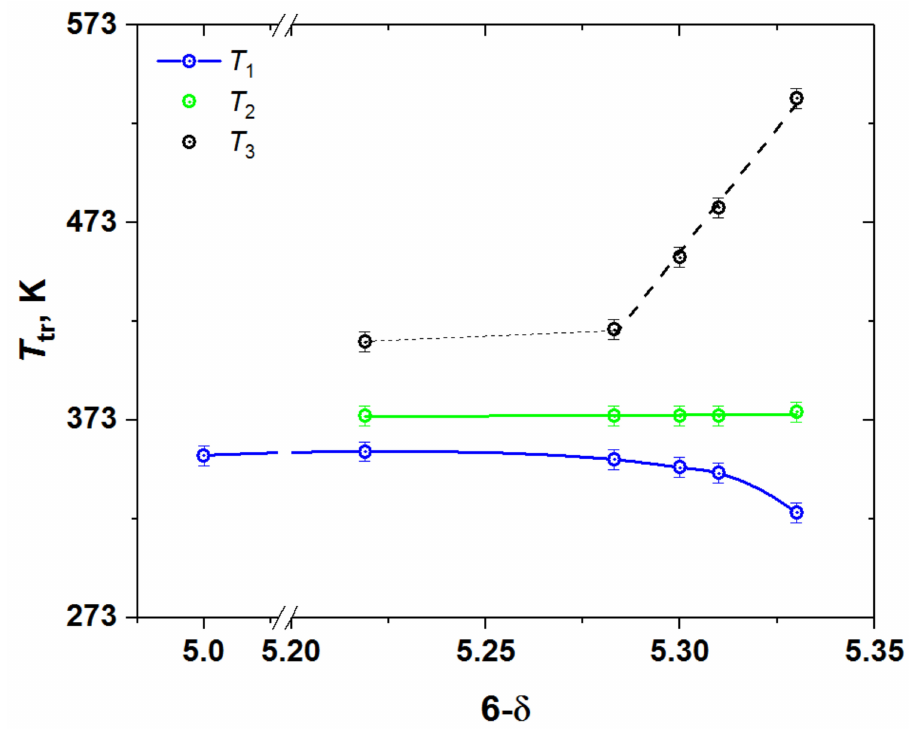
Figure 3. The phase transition temperatures in YBC as functions of its oxygen